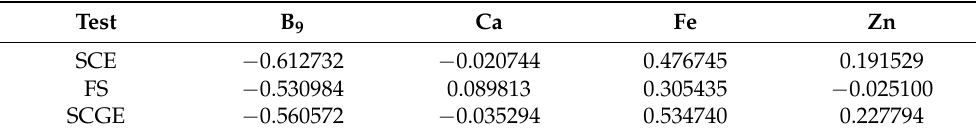
Table 3. Correlations between levels of damage and the content of selected minerals and vitamins in the blood.